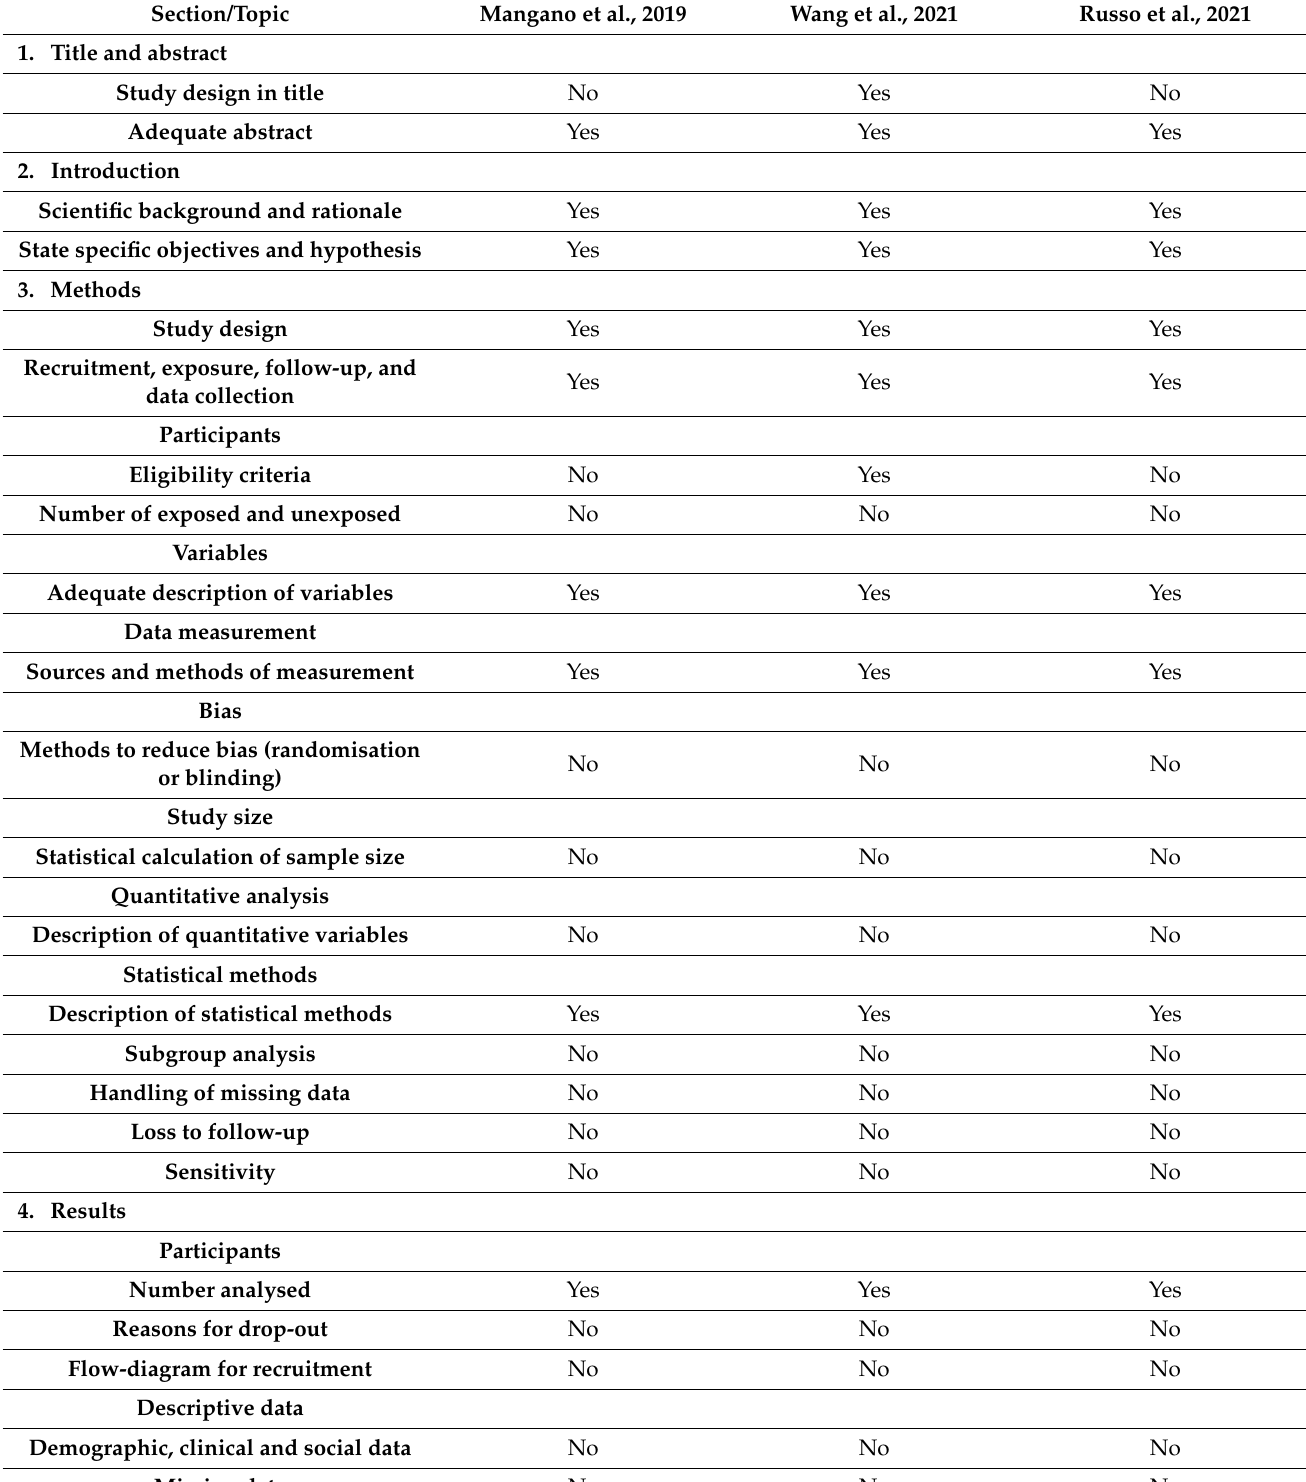
Table 5. Quality assessment of the observational studies included in this